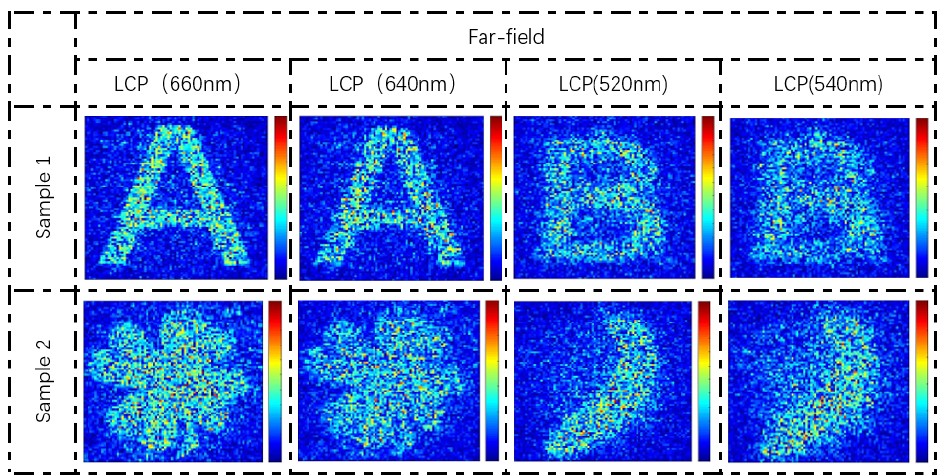
Figure 8. The simulation results of broadband response. The results include the holographic images by illuminating the metasurface under LCP light at different wavelengths (660 nm, 640 nm, 520 nm, 540 nm).